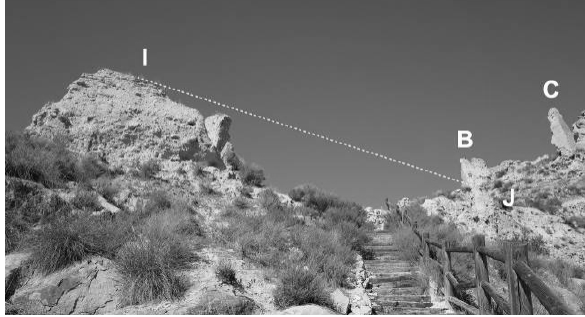
Figure 3. View of the east elevation of the castle.